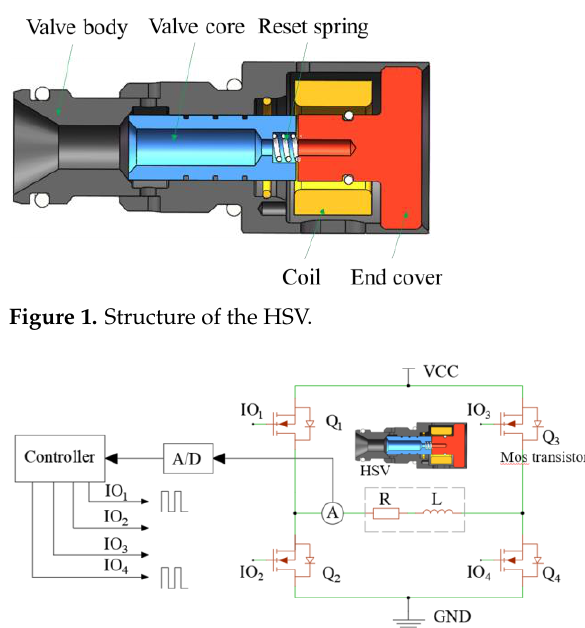
Figure 1. Structure of the HSV.